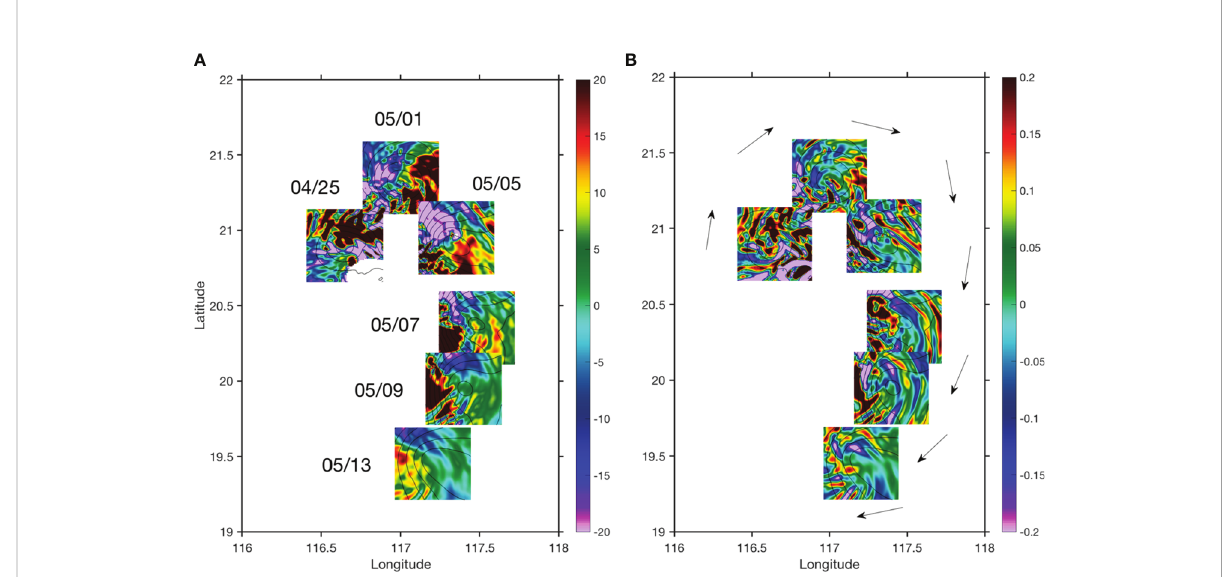
FIGURE 8 Distributions of vertical velocity (A units: m d -1 ) at 80 m and normalized current divergence (A) at 50 m following the propagation the submesoscale eddy of case1. The arrows in (B) illustrates the general moving directions of the